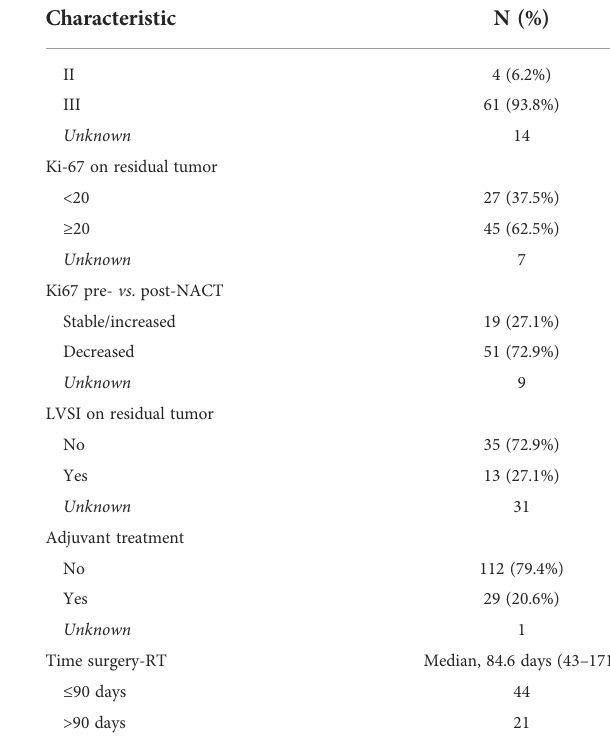
MRI, magnetic resonance imaging; NACT, neoadjuvant chemotherapy; SLNB, sentinel lymph node biopsy; LN, lymph node; pCR, pathological complete response; LVSI, lymphovascular space invasion; RT,